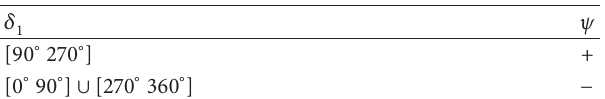
Table 2: Symbol of 𝜓 .